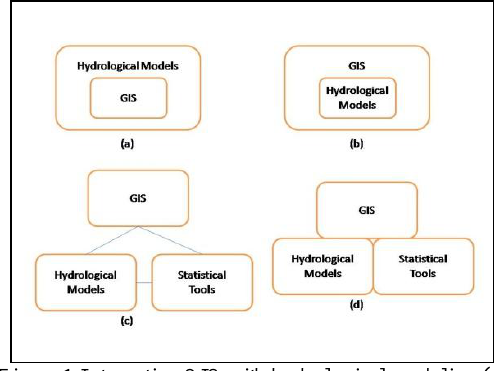
Figure 1 Integrating GIS with hydrological modeling (a) Embedding GIS in Hydrological models (b) Embedding hydrological models in GIS (c) Loose coupling (d) Tight coupling (Adapted from Sui & Maggio,